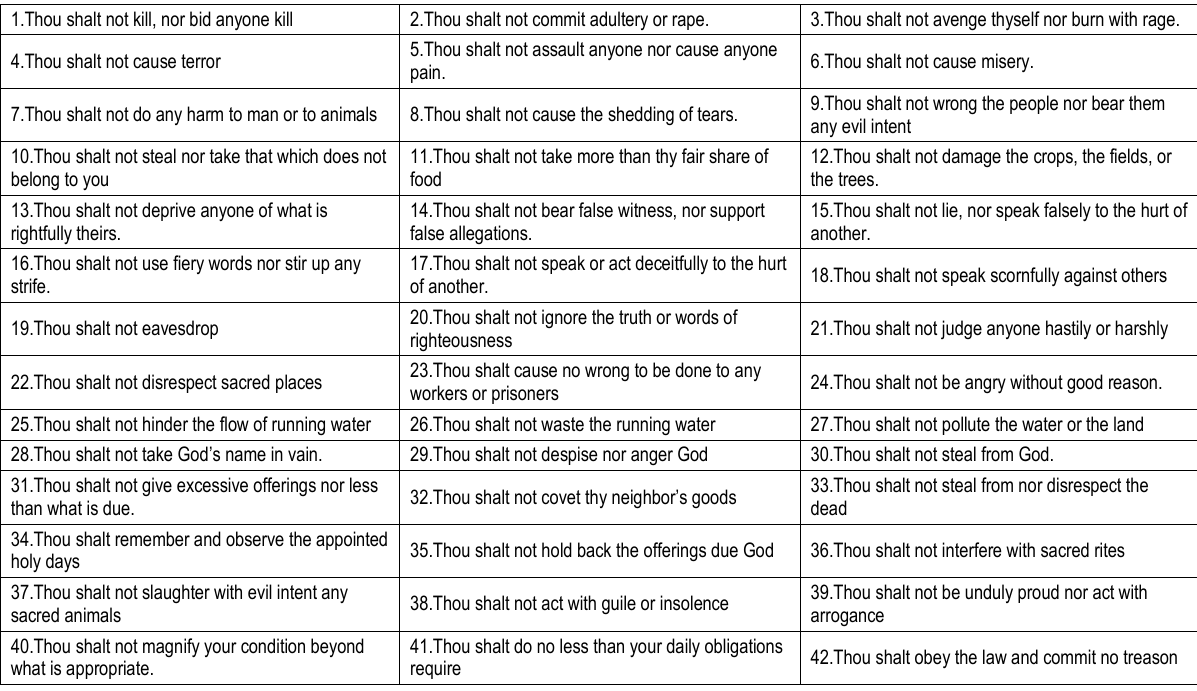
Table 1. The 42 ethical